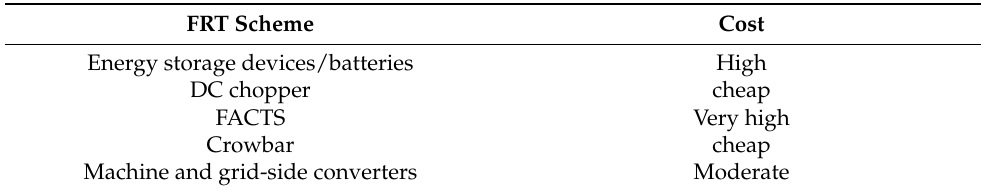
Table 4. Economic